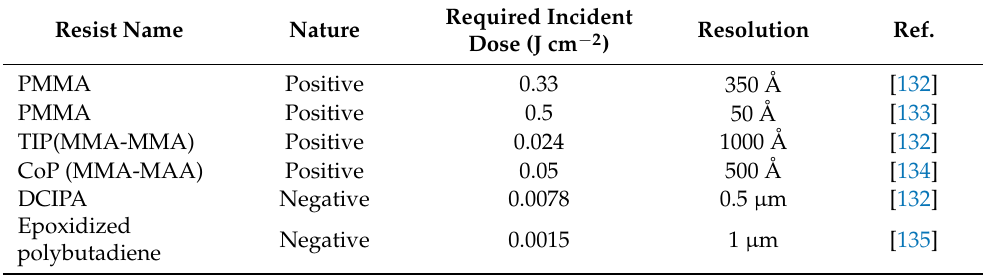
Table 4. Different resists for X-ray lithography